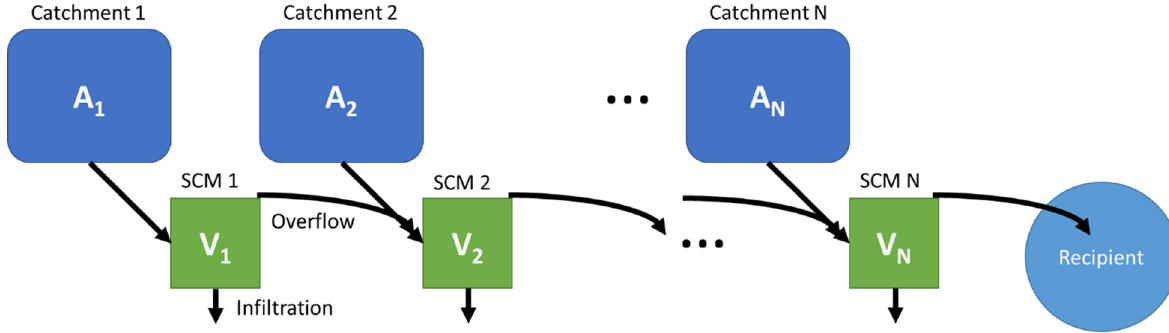
Figure 1. Illustration of N sub-catchments with associated stormwater control measures (SCMs) in series.